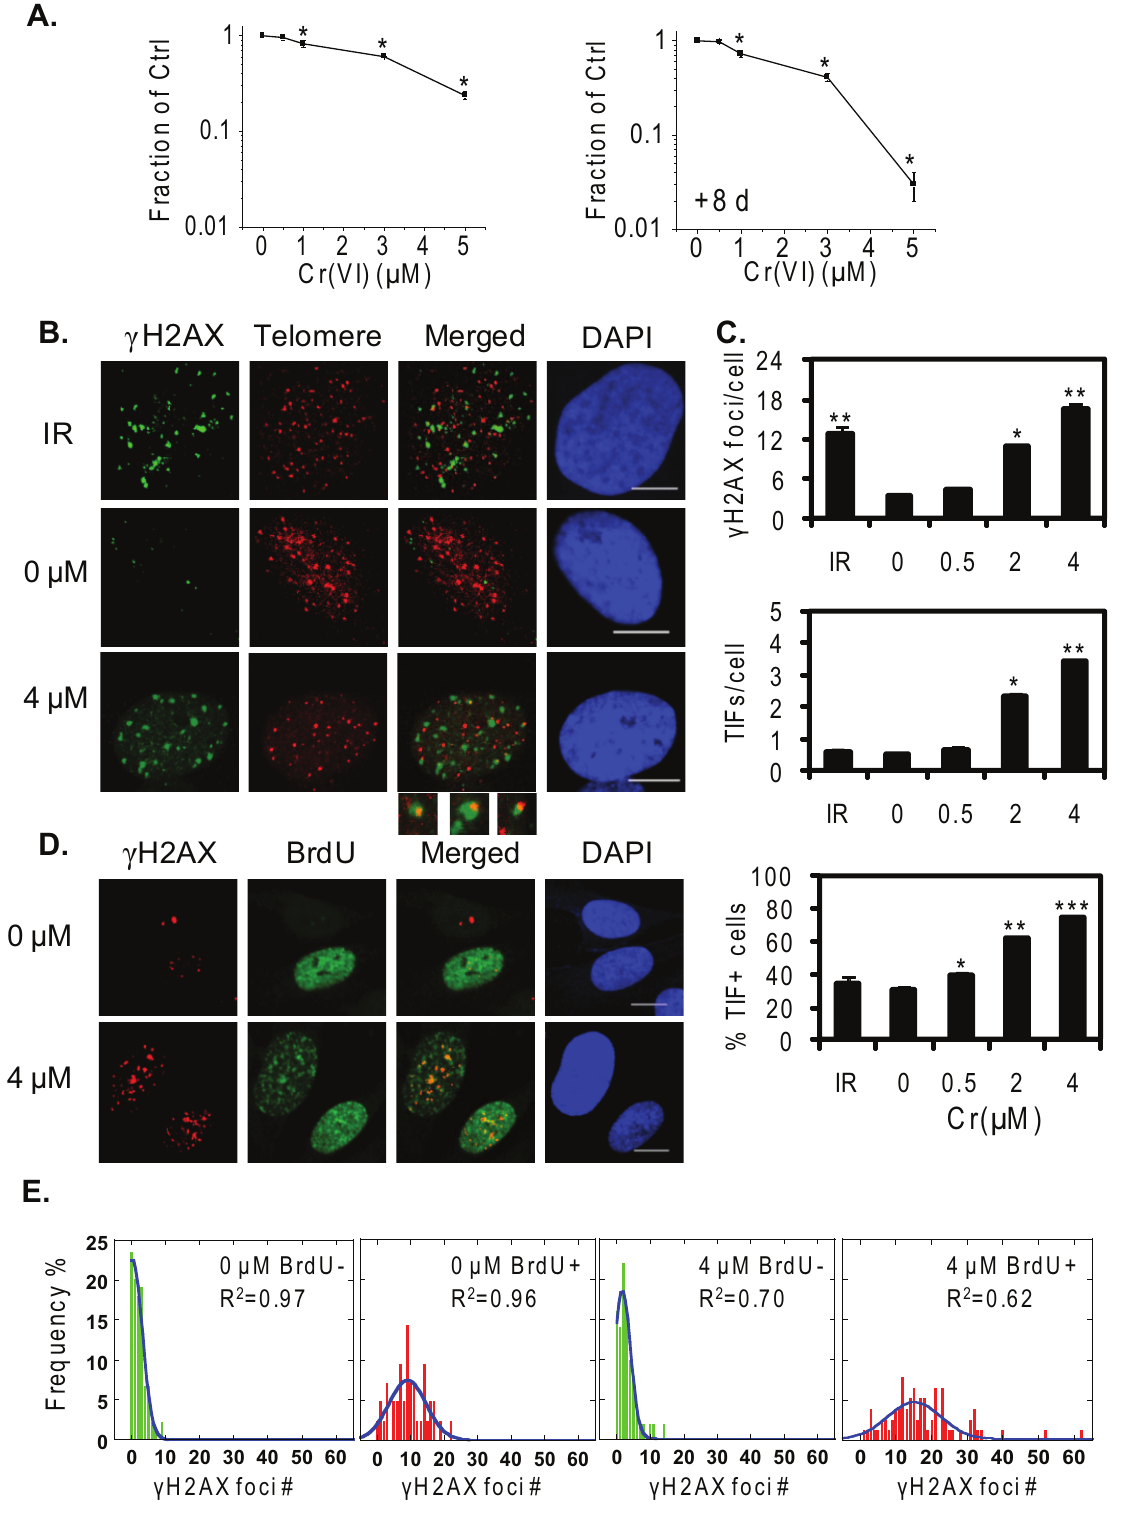
Figure 2. Cr(VI) induces replication-associated TIFs in lung fibroblasts. (A) Cellular toxicity of Cr(VI) upon 48 h exposure followed by no recovery or an 8-day recovery of a subpopulation of WI-38 cells in Cr(VI)-free medium. The symbol (*) indicates a significant difference from untreated in the indicated Cr(VI) concentration (p , 0.05). (B) Confocal images of WI-38 cells exposed to the indicated Cr(VI) concentrations for 48 h. Cells were subjected to IF-FISH for analysis of c H2AX (green) and telomere (red) colocalization (yellow). IR: 1 Gy treatment, followed by IF-FISH after 1 h recovery. Bars, 10 m m. (C) Average c H2AX foci and TIF number per cell and the percent of TIF positive cells (% TIF + cells). The % TIF + cells represent the percentage of cells containing at least one TIF foci. The data represent mean 6 SE from two independent experiments, based on at least 50